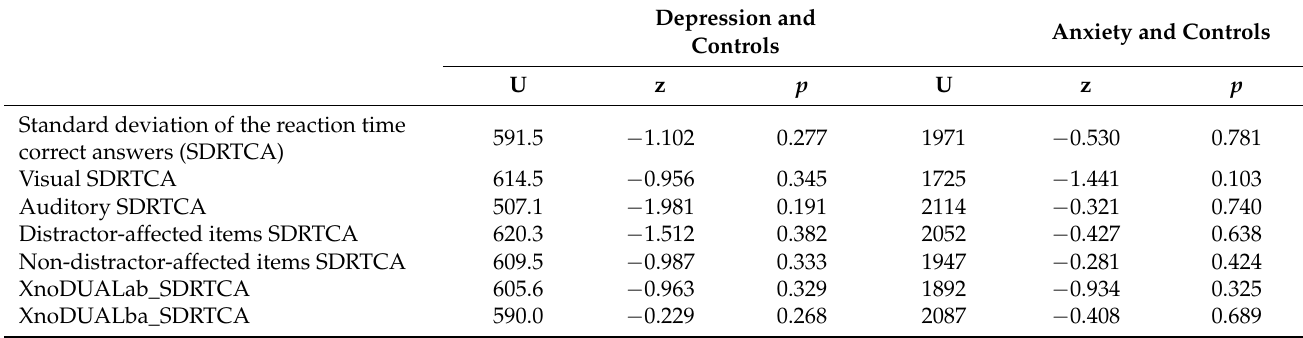
Table 5. Contrast of means between groups with depression and anxiety and controls. Sustained attention.